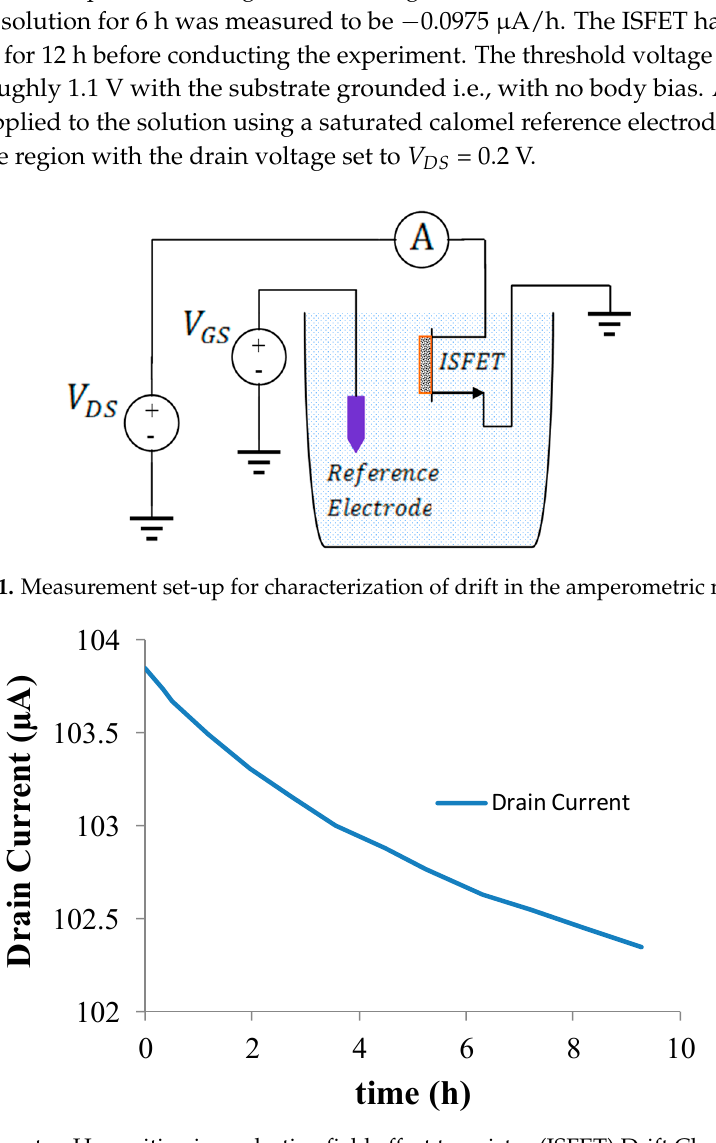
Figure 2. Si 3 N 4 -gate pH-sensitive ion-selective field effect transistor (ISFET) Drift Characteristics at pH = 7.